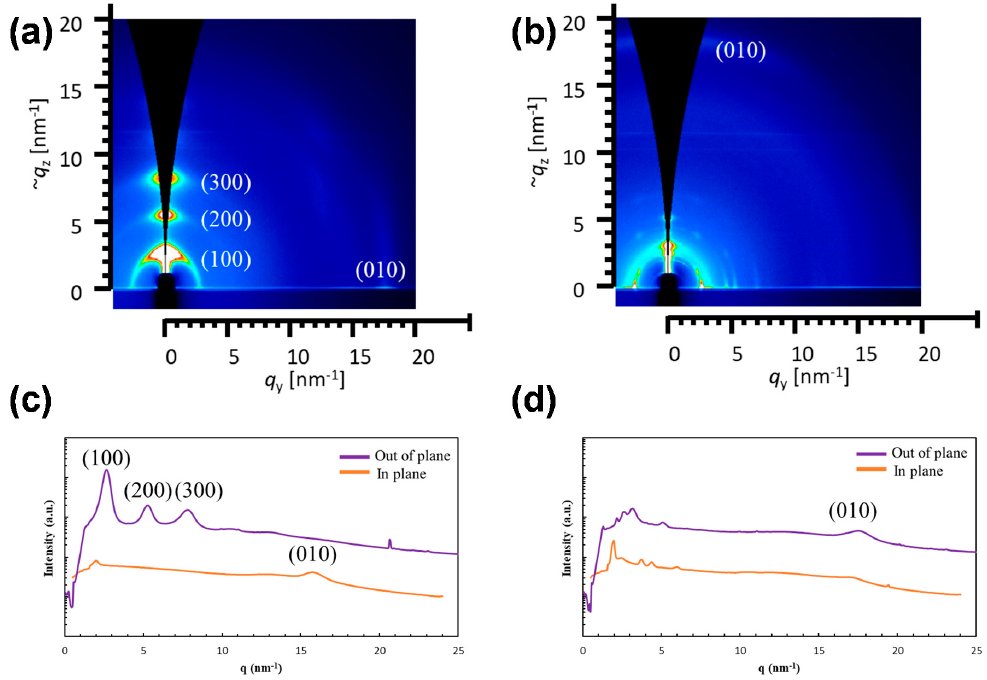
Figure 3. 2D grazing-incidence wide-angle X-ray scattering (GIWAXS) images and 1D-GIWAXS profiles of the thin film of POTV. ( a , c ) as-cast film, ( b , d ) annealed at 200 °C.